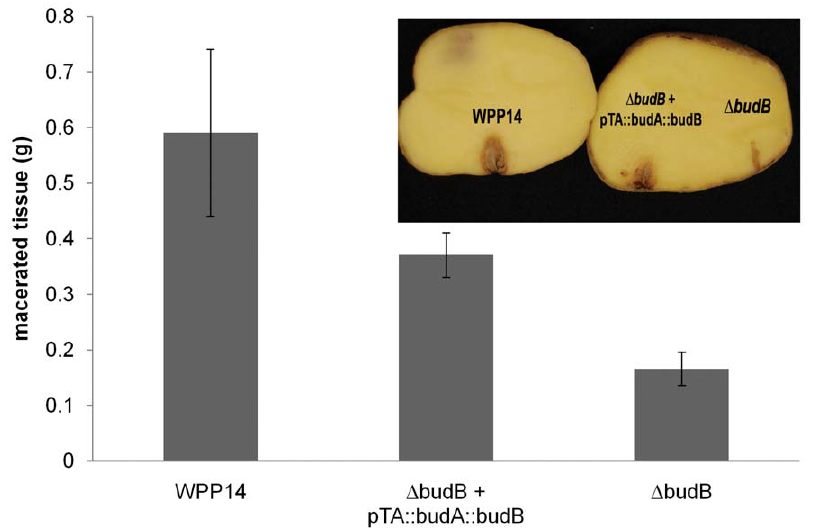
Figure 4. WPP14 D budB is reduced in virulence in potato tubers. Potato tubers (n=10) were inoculated with 10 6 CFU, placed into plastic bags and incubated at 28 u C for 3 days. After incubation, macerated tissue was scooped out and weighed. The graph shown is from one experiment. This experiment was repeated twice with similar results. Error bars indicate standard error.